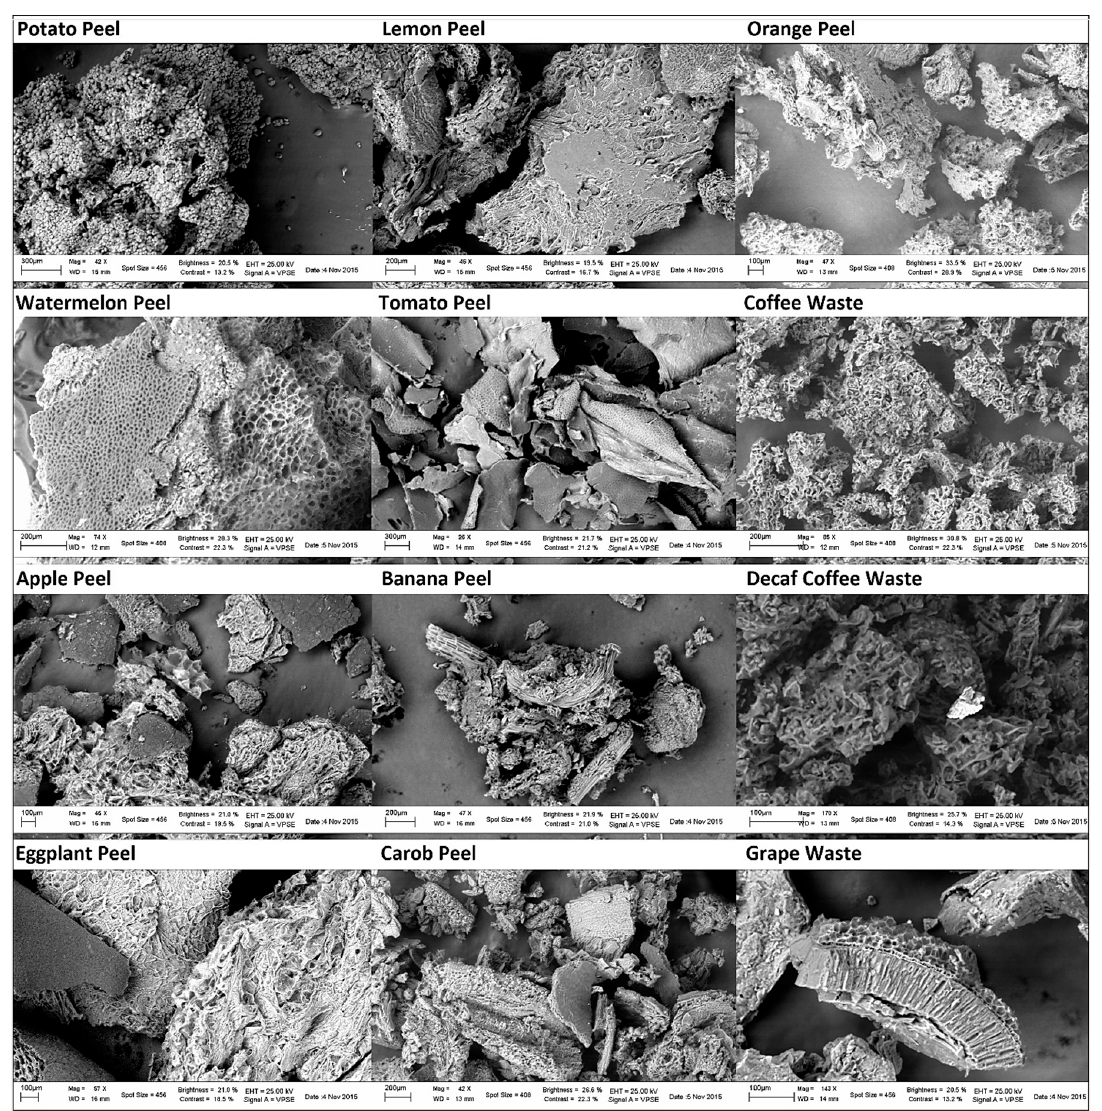
Figure 1 . Adsorbent surfaces ′ micrographs (at 100, 200 and 300 µm) obtained by scanning electron Figure 1. Adsorbent surfaces (cid:48) micrographs (at 100, 200 and 300 µ m) obtained by scanning electron microscopy (SEM). microscopy